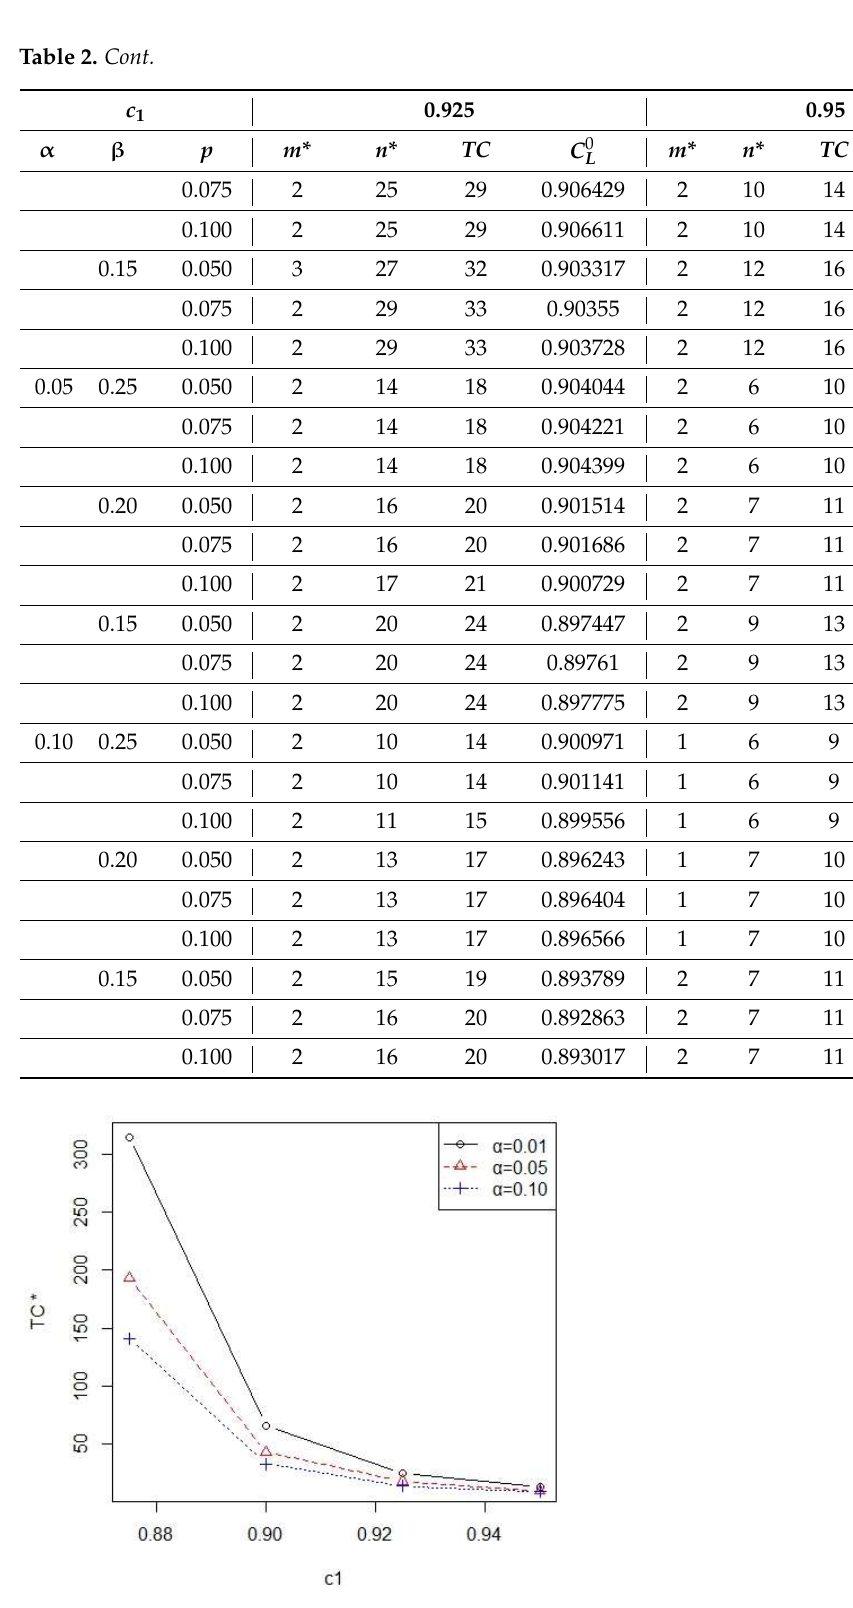
Figure 3. Minimum total cost curve for α = 0.01, 0.05, 0.1 at β = 0.25 and p = 0.05.